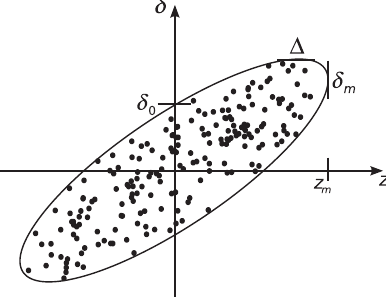
FIG. 3. Rotated ellipse in phase space (cid:7) , z . (cid:2) ¼ (cid:7)p=p 0 is the maximum momentum spread, (cid:7) 0 ¼ ð (cid:7)p=p 0 Þ 0 the maximum momentum deviation in the center, and (cid:7) momentum offset at the ends.